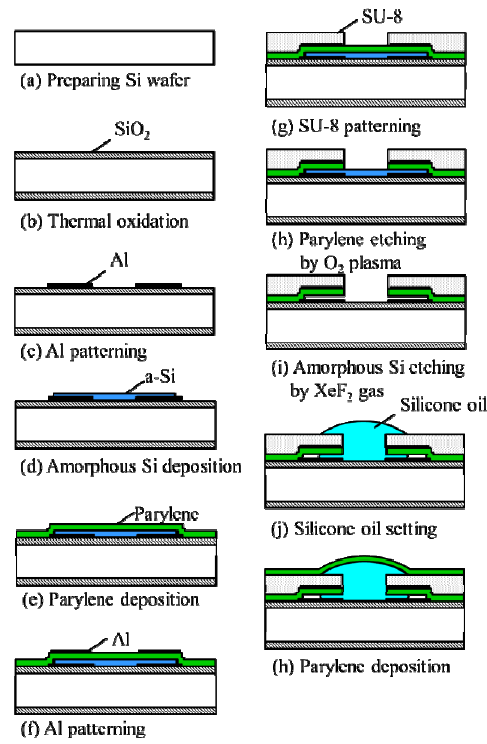
Figure 7. Fabrication process of forced